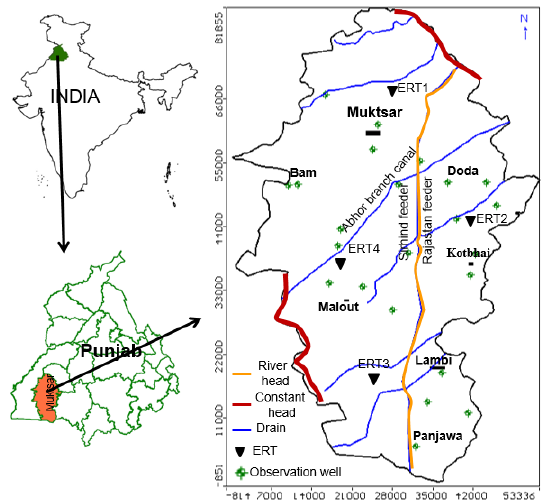
Figure 1. Location of the Muktsar district and targeted observation wells for the calibration (the x - and y -axes are in